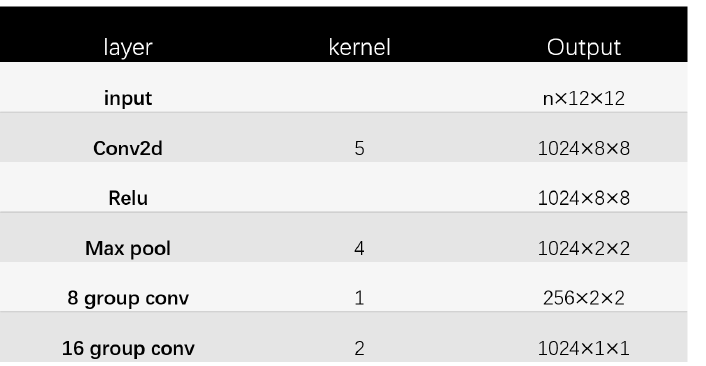
Figure 4. CNN structure diagram in Glyce.